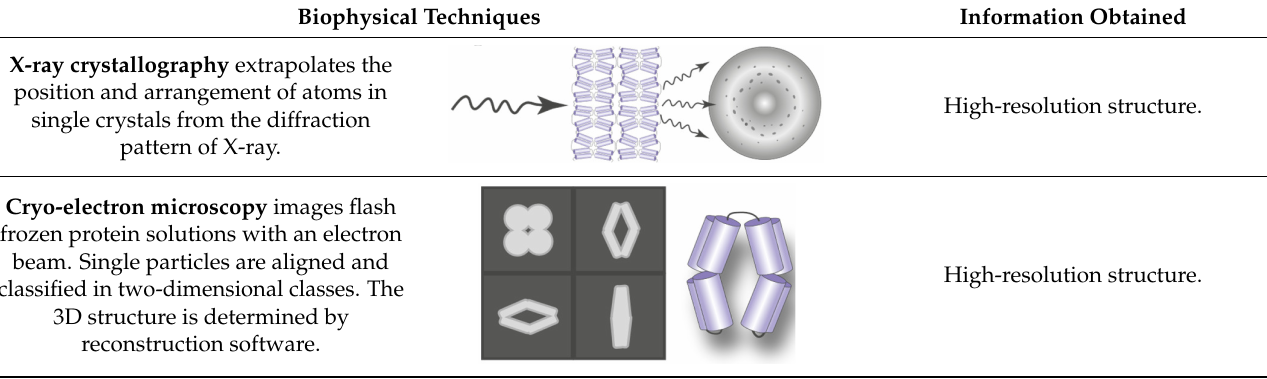
Table 1. Representative biophysical techniques used to study the lipid–protein interactions of